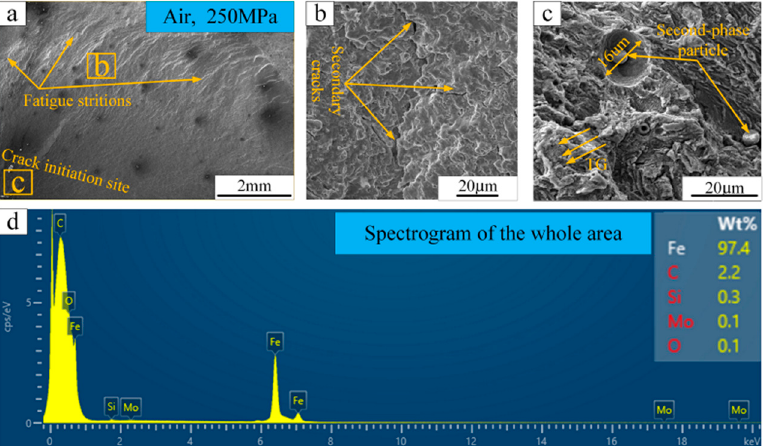
Figure 5. Fracture surfaces of X80 steel welded joints in air. ( a ) The entire fracture surface; ( b , c ) the high magnifications of the boxed areas in ( a ); ( d ) the elements distribution of ( c ).